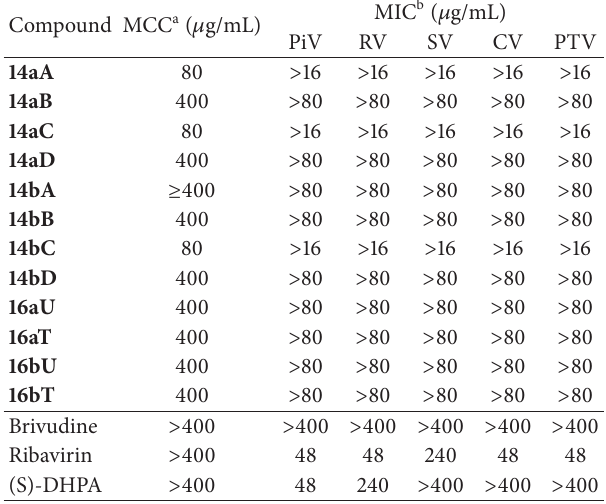
Table 3: Cytotoxicity and antiviral activity of compounds 14a,b and 16a,b in HeLa cell cultures. Compound